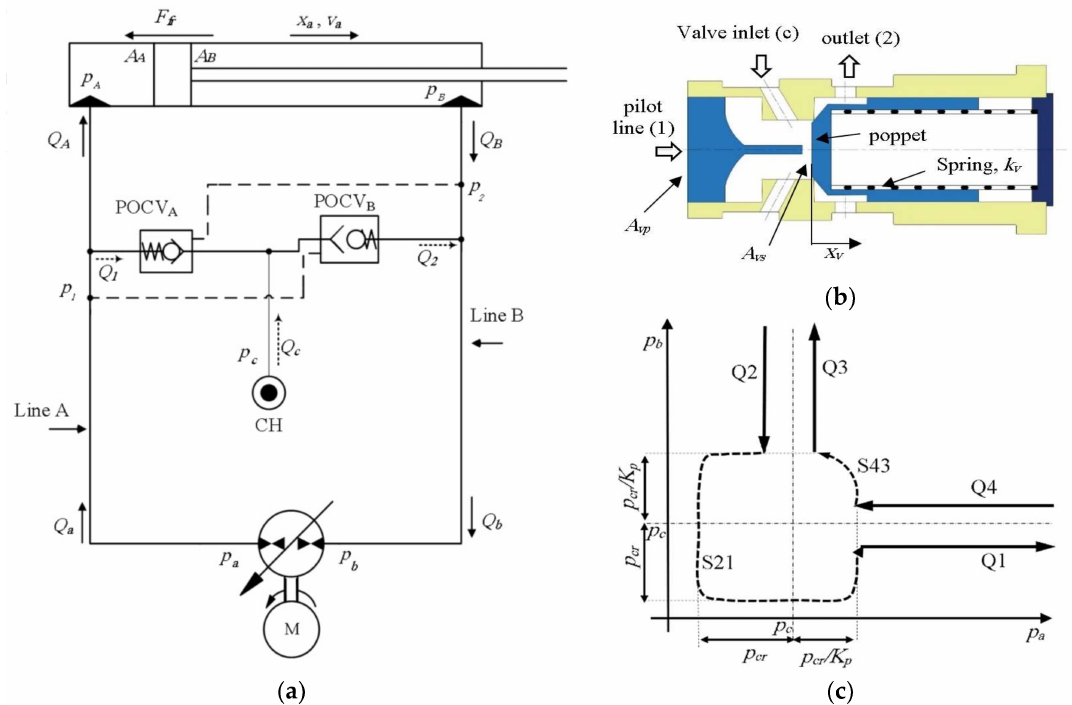
Figure 5. Circuit with pilot-operated check valves to compensate for cylinder differential flow: ( a ) schematic drawing of circuit; ( b ) drawing of pilot-operated check valve (POCV); ( c ) expected pressure plane performance at critical